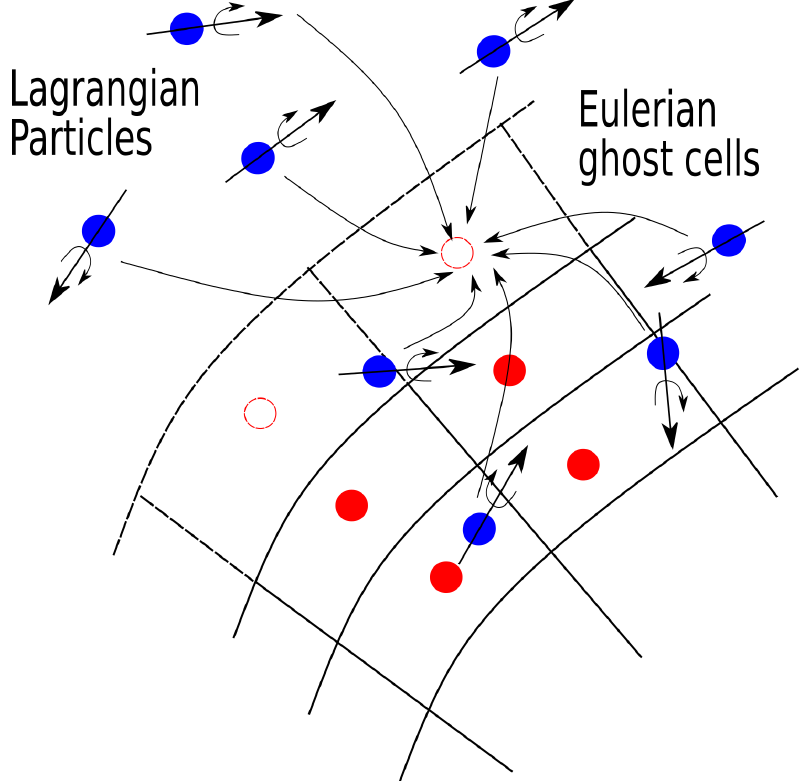
Figure 2. The Lagrangian particle solution is used to define the far-field boundary conditions of the Eulerian solver. Lagrangian particles are depicted as solid blue circles. Solid and dotted red circles denote the centers of the Eulerian cells and ghost cells,